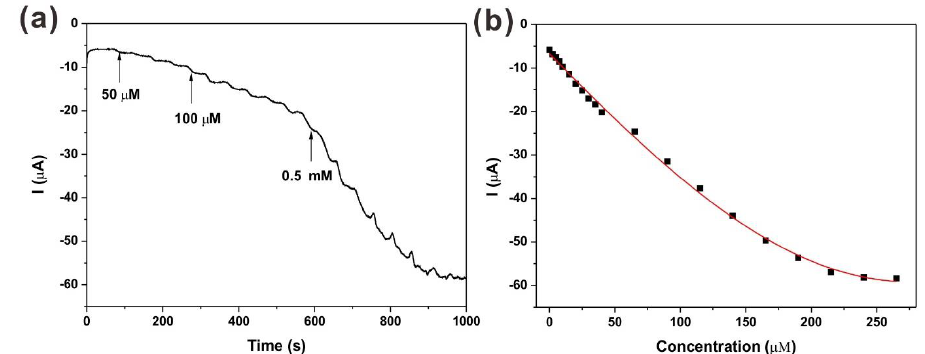
Figure 6. ( a ) Chronoamperometric responses of ZIF-67/CNFs/GCE on successive addition of different volume of H 2 O 2 solutions into 0.1 M NaOH solution, applied potential: − 0.2 V; ( b ) The calibration curves with nonlinear fitting. Table 1. Sensing performance comparison of different non-enzymatic sensor toward H 2 O 2 1 .